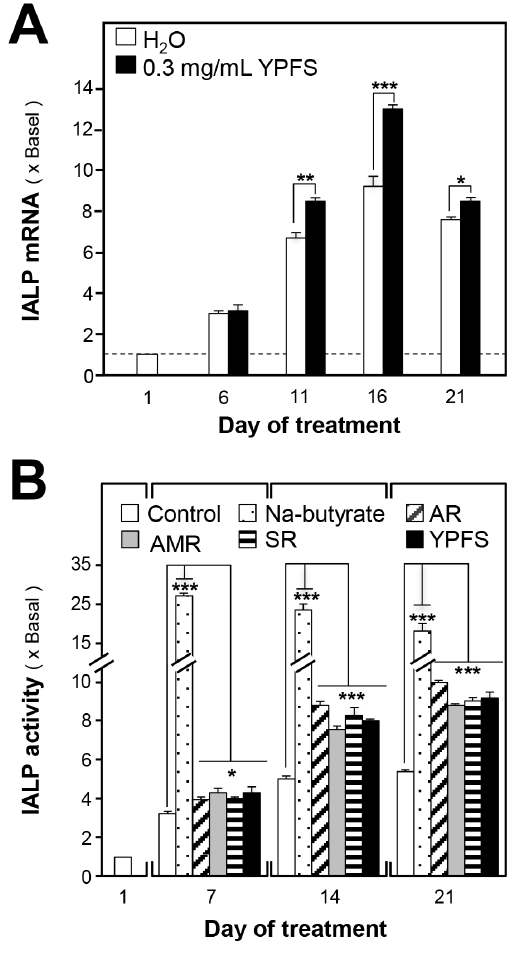
Figure 3. YPFS stimulates IALP expression and activity in Caco- 2 cells. ( A ): Caco-2 cells (100,000/well) cultured in 6-well plates were treated with herbal extracts and cells were harvested on various days. IALP mRNA levels were quantified using RT-PCR, and the values were normalized relative to GAPDH expression. ( B ): Caco-2 cells (50,000/well) cultured in 12-well plates were treated with herbal extracts. Cells were harvested on various days as in (A) and extracts were prepared using a lysis buffer (pH 10.4). IALP activity in Caco-2 cells was measured by mixing samples with 5 mM p-nitrophenyl phosphate, and absorbance was measured at 405 nm; enzyme activity is expressed as m mol cleaved substrate/mg protein. Here, sodium butyrate (1 mM) served as the positive control. Values are expressed as fold-increases relative to basal reading (taken on the first day of culture); mean 6 SD are shown, n= 3, each with triplicate samples. * p , 0.05; ** p , 0.01; *** p ,